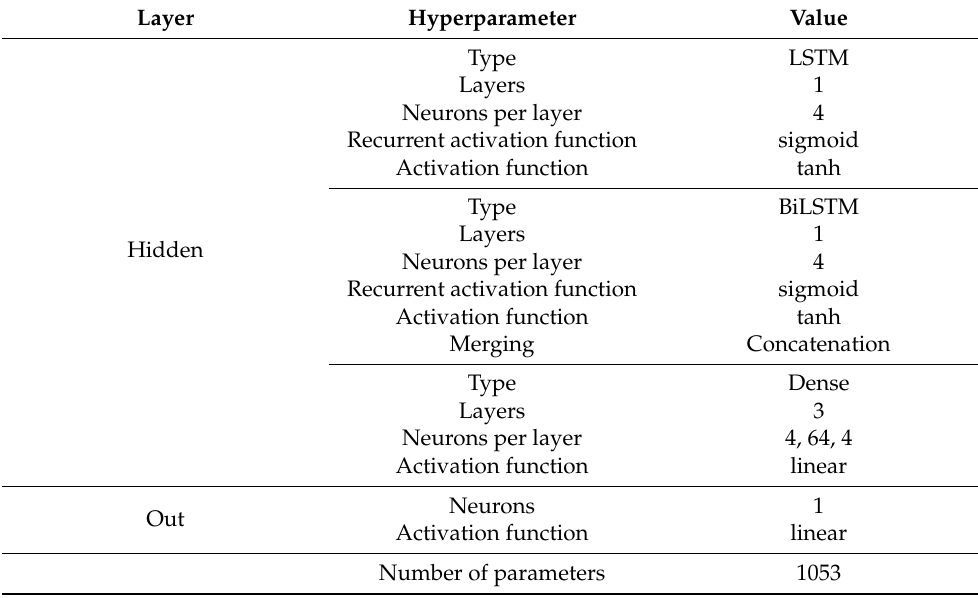
Table 4. Sun’s architecture hyperparameters